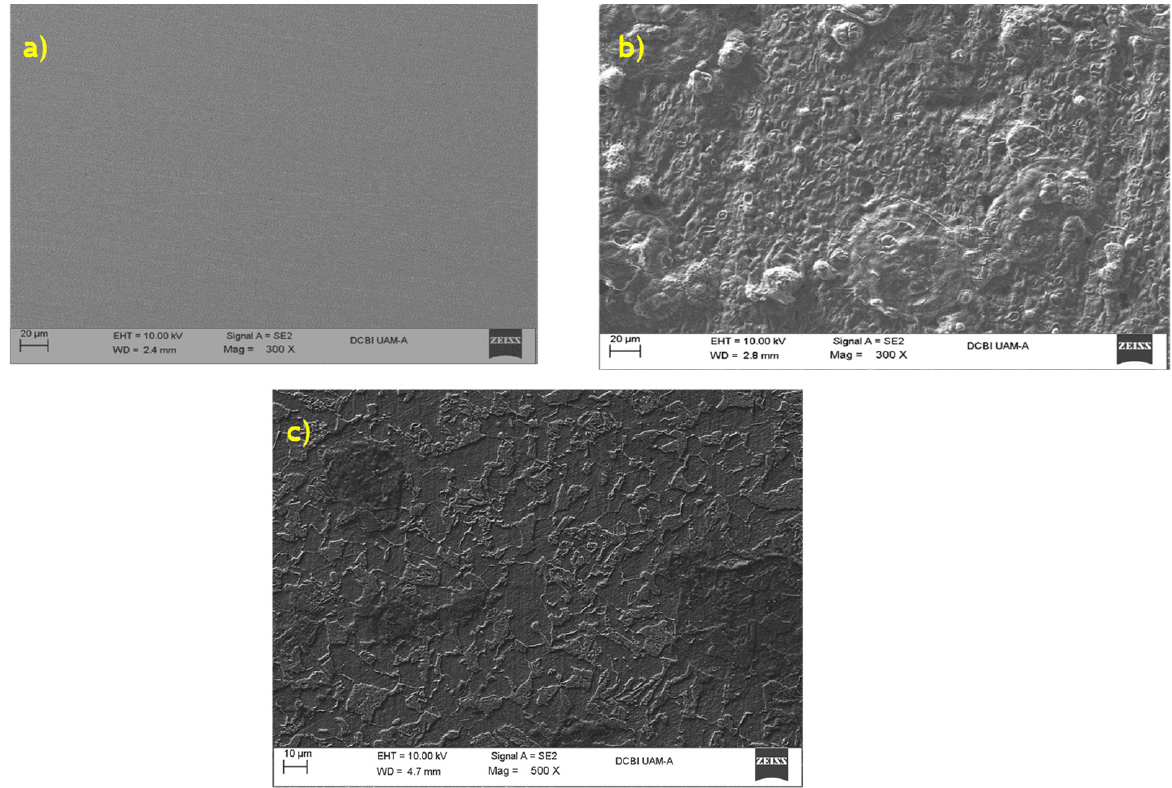
Figure 11. SEM images at 300 X of ( a ) AISI 1018 steel with no-inhibitor; ( b ) AISI 1018 steel immersed in NaCl + CO 2 ; ( c ) 10 ppm 4-PC+ NaCl + CO 2 after 24 h.